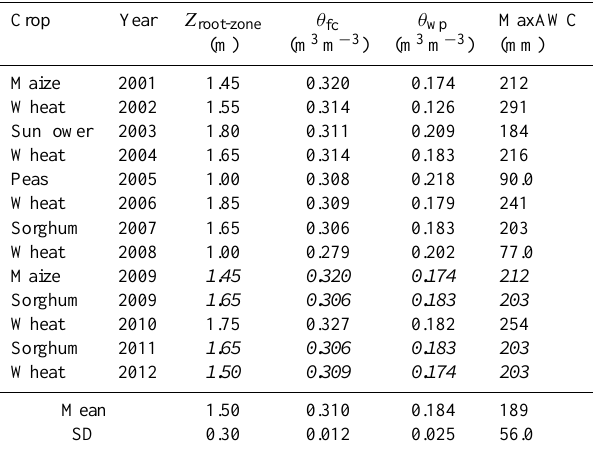
Table 3. Estimates of the rooting depth ( Z root-zone ), the soil mois- ture at field capacity ( θ fc ) and the soil moisture at wilting point ( θ wp ) derived from the time evolution of vertical profiles of field- measured soil moisture. MaxAWC (maximum available soil water capacity; in mm) represents the maximum root-zone water stock available for the crop. When no measurements were available, the mean value (in italic) from a similar crop type was used. The last two rows are the mean and the SD (standard deviation) computed over all crop